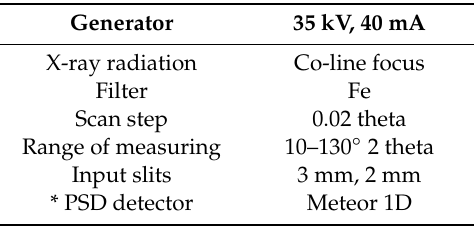
Table 3. Measurement